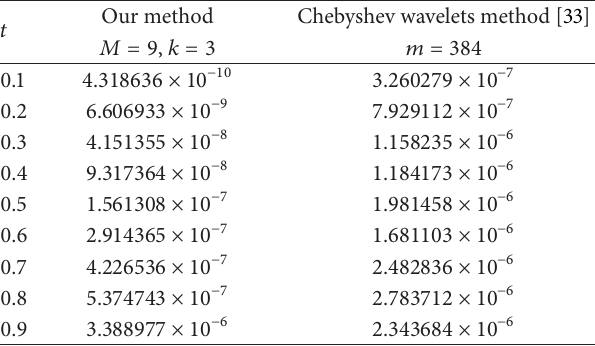
Table 2: Comparison of absolute error in solution of our method and reported in [33] for Example